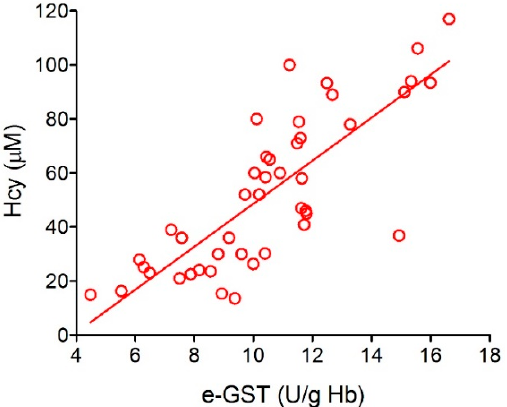
Figure 7. Linear correlation between homocysteine and erythrocyte glutathione transferase activity. Homocysteine (Hcy) is reported in μ M and e-GST activity in U/g Hb (modified from Reference [38] ).